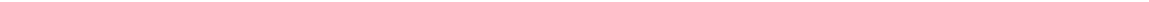
Fig. 6 Centriole over-elongation leads to the formation of over-active centrosomes. a , b Overly long centrioles recruit more pericentriolar material than normal-length centrioles. a RPE-1 (control, only normal-length centrioles) and MDA-MB-435 (with normal-length and overly long centrioles) cells were stained with DAPI (blue), centrin (green), and γ -tubulin or pericentrin, (PCM components, red) antibodies (for details see Supplementary Fig. 11a